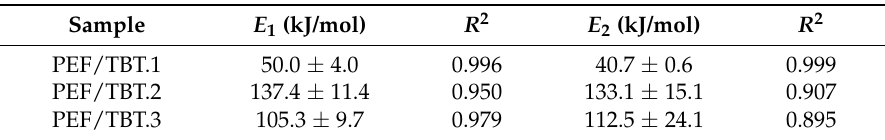
Table 3. Activation energies and correlation coefficients of the transesterification and esterification reaction of all PEF/TBT